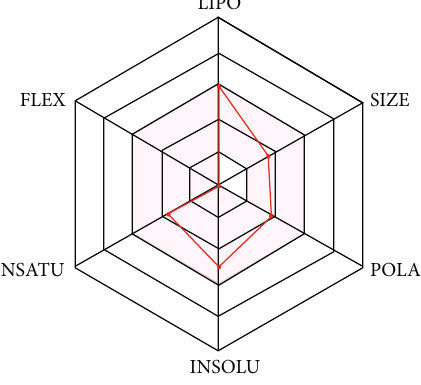
Figure 4: Bioavailability radar by SwissADME tool (Pink area in the fi gure represents optimal range of particular property) for compound 1. (LIPO: lipophilicity; SIZE: size as molecular weight; POLAR: polarity asTPSA; INSOLU: insolubility in water; INSATU: insaturation as per fraction of carbons in the sp3 hybridization; FLEX: fl exibility as per rotatable